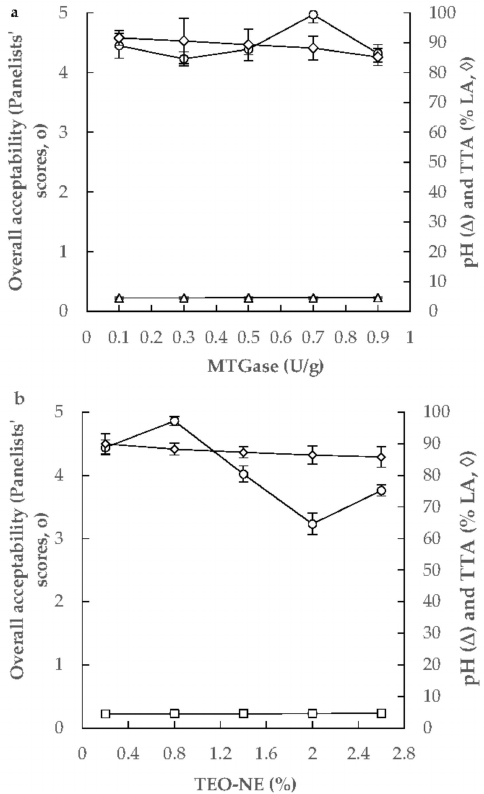
Figure 5. Changing the TTA, pH, and overall sensory acceptability of yogurt gels as a function of MTGase (0.1–0.9 U/g, with 0.75% TEO-NE) ( a ) and TEO-NE (0.2–2.6%, with 0.70 U/g MTGase) concentrations ( b